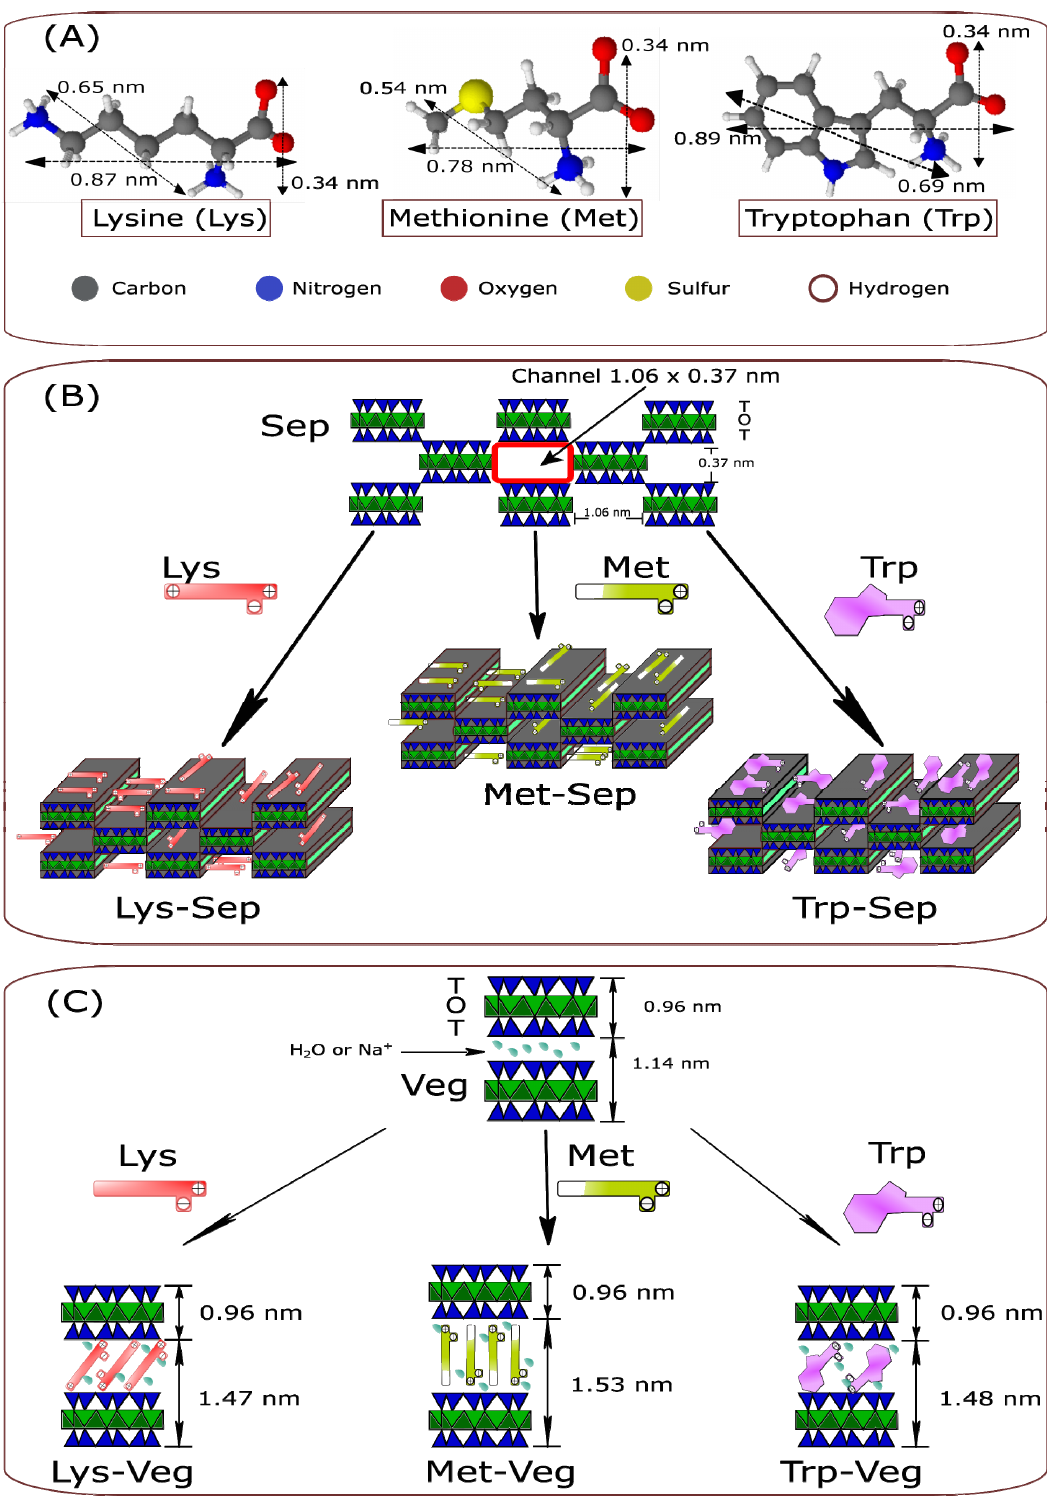
Figure 2. ( A ) Schematic illustration for molecular structures of amino acids and their dimensions (calculated using Chem Sketch 12.0 software (ACD/Labs, Toronto, ON, Canada)). Proposals for the incorporation of amino acids in ( B ) Sep and ( C ) Veg.